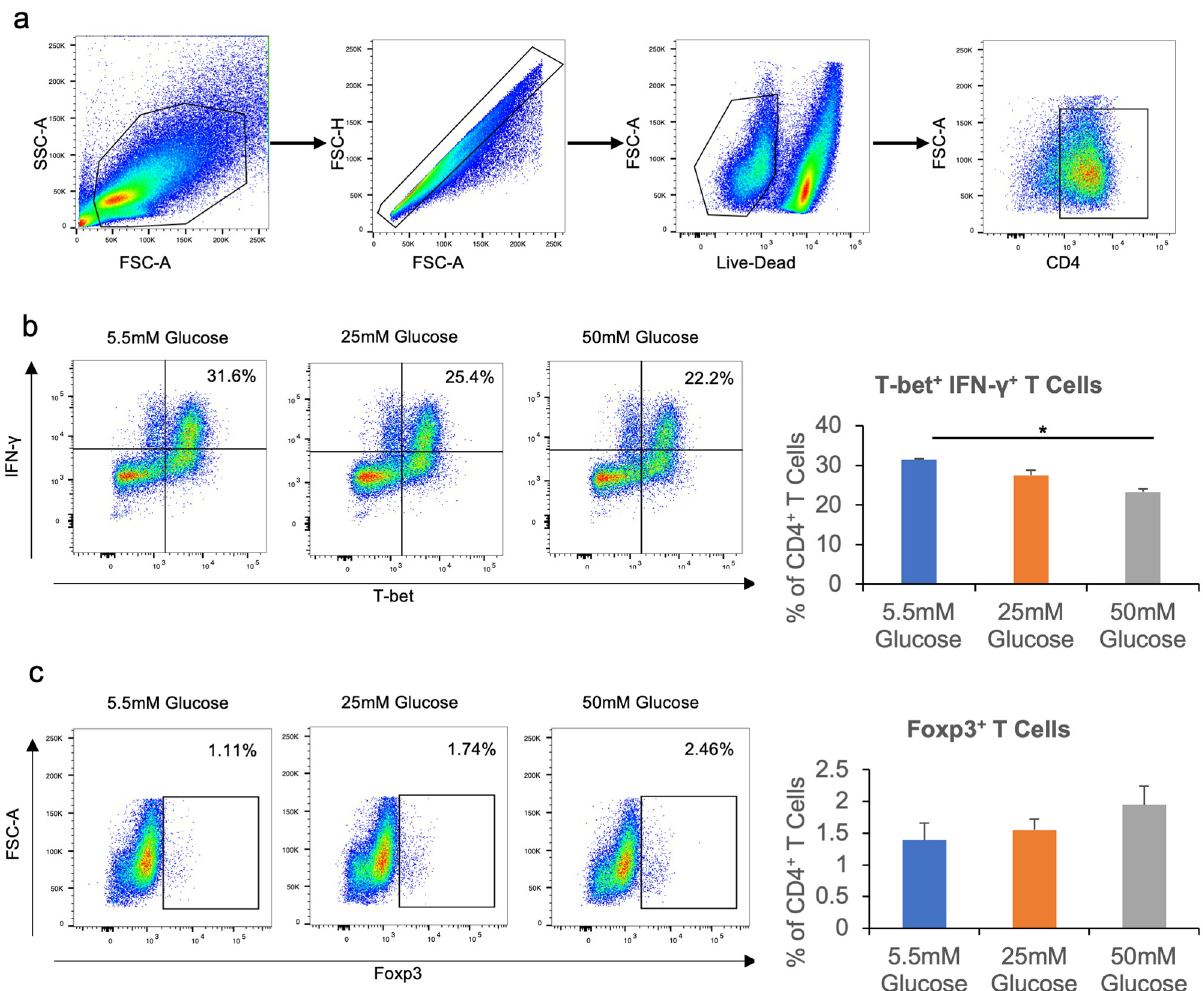
Fig 2. High glucose inhibits Th1 differentiation. Na ï ve CD4 + T cells were isolated from C57BL/6 mice and cultured for 72 hours in 96-well plates with plate-bound anti-CD3, and soluble anti-CD28, anti-IL-4, IL-12, and IL-2. Cells were then stimulated with Cell Stimulation Cocktail for 4 hours before staining with fluorescence-conjugated antibodies and analyzed with flow cytometry. a , Representative flow cytometry gating for CD4 + T cell populations. b , Percentages of CD4 + T-bet + IFN- γ + T cells in all CD4 + cells. c , Percentages of CD4 + Foxp3 + T cells in all CD4 + cells. N = 3, and data are presented means ± S.E.M. � p < 0.05 by Student’s t